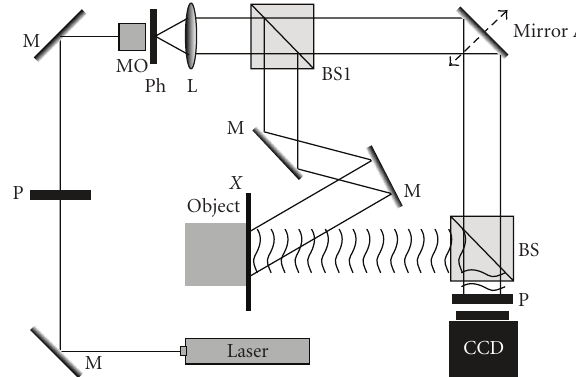
Figure 1: Schematic depicting a typical inline DH setup. M: Mirror, P: Polarizer, BS: Beam Splitter, Ph: Pinhole, and MO: Microscope